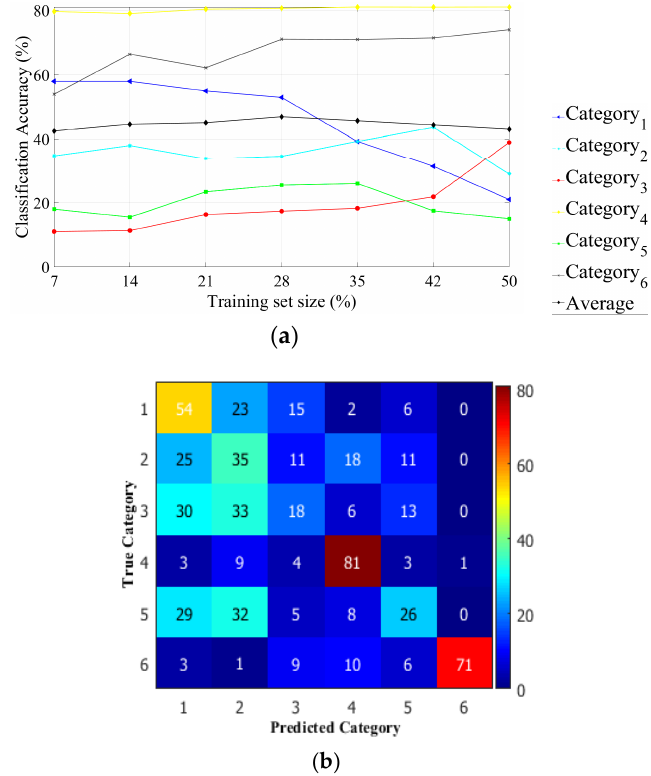
Figure 23. The topographies classification performance of the multiscale BP data set: ( a ) the effect of increasing the training set size on the classification accuracy and ( b ) a confusion matrix for six surface category classifications by using 28% of the BP data set for training .